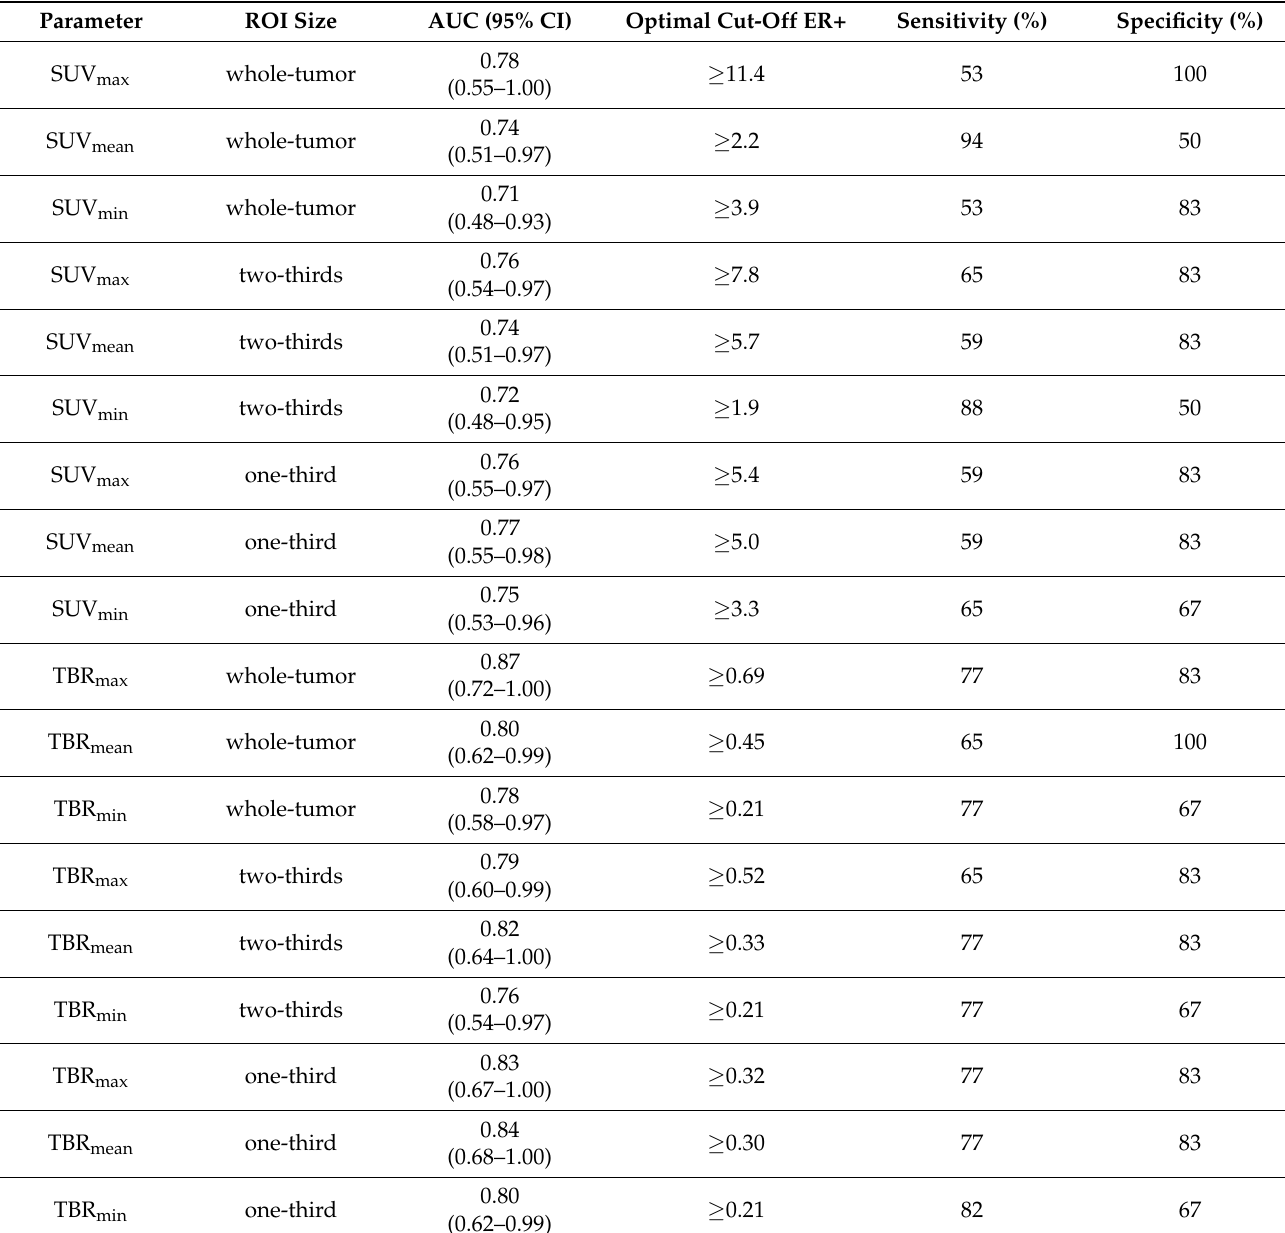
Table 2. The discriminative power of [ 18 F]-FES-PET to stratify liver metastases by ER status ( n =